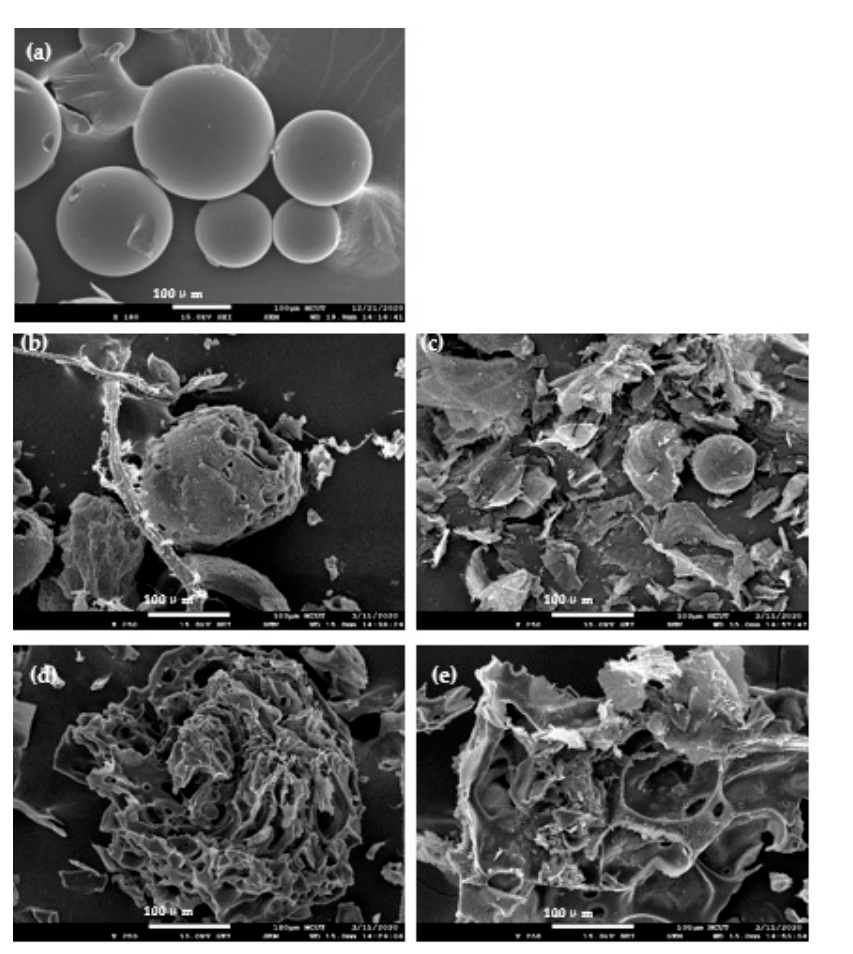
Figure 1 . Scanning electron microscope view of the topography of ( a ) raw phenolic resin waste; activated carbon (AC) impregnated in phosphoric acid and subjected to ( b ) microwaves (AC P-MW ) or ( c ) electric heating (AC P-EH ); AC activated using KOH and subjected to ( d ) microwaves (AC K-MW ) or ( e ) electric heating (AC K-EH ).